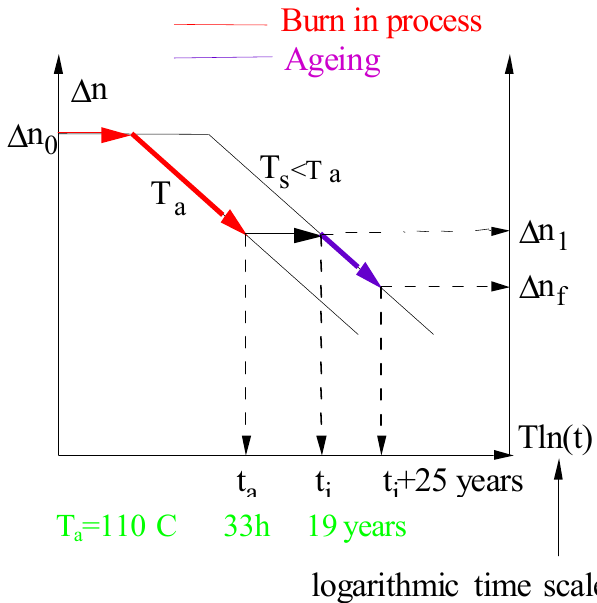
Figure 36. Scheme of the passivation process (also called burn-in process in this figure). Δ n 0 is the FBG index modulation (or its reflectivity) before the passivation process at the temperature T a for a given time t a . Δ n 1 is the FBG index modulation after the passivation process. Δ n f is the final value of the index change after its life for a time t use at a given temperature T use